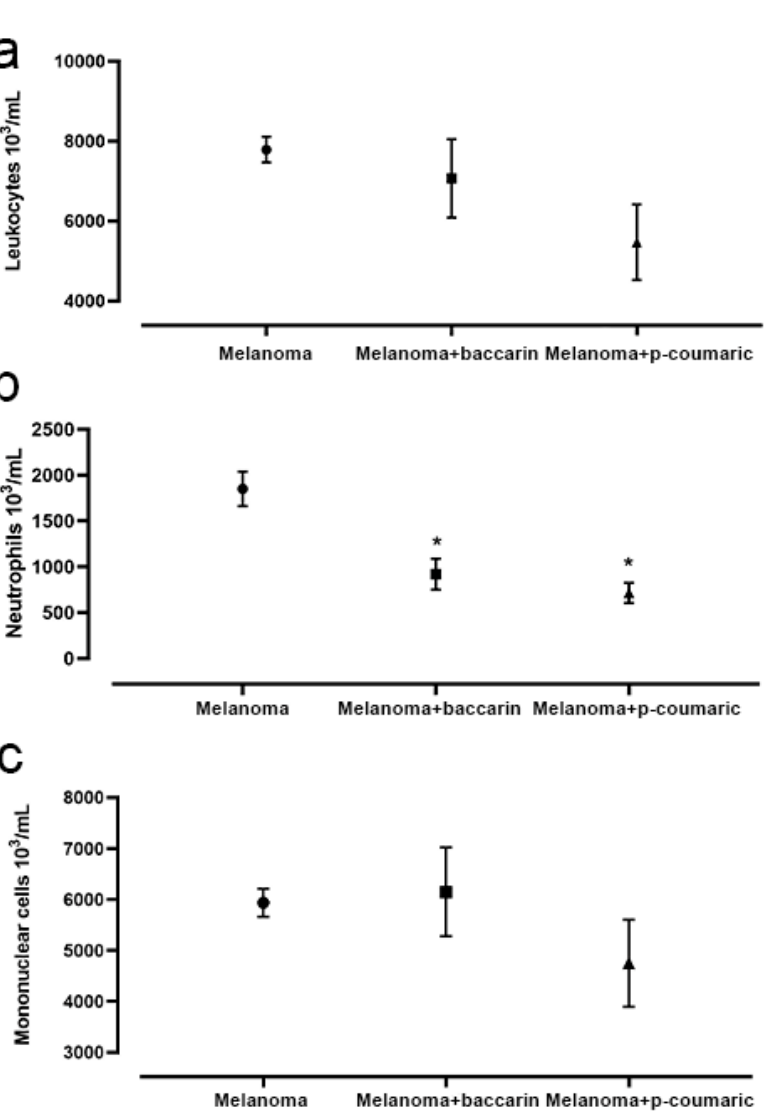
Figure 6. Representative graphic of the analysis of total leukocytes ( a ), neutrophils ( b ), and mononuclear cells ( c ) in peripheral blood. There were no significant differences in the analysis of total leukocytes and mononuclear cells between the experiments under tumor conditions. However, there was a reduction in the number of neutrophils in the Melanoma + baccarin and Melanoma + p-coumaric acid groups compared to that of the Melanoma group. Comparison between the Control and Melanoma groups (B16F10 concentration of 10 6 cell/mL) that ingested only PBS and the baccarin or p-coumaric and Melanoma + Baccarin groups that received treatment with the baccarin compound (500 μ g/kg) for 26 days and the Melanoma + p-coumaric acid group that received treatment with p-coumaric compound (500 μ g/kg) for 26 days. Data represents mean ± SEM. *These differences were considered significant with p < 0.05.